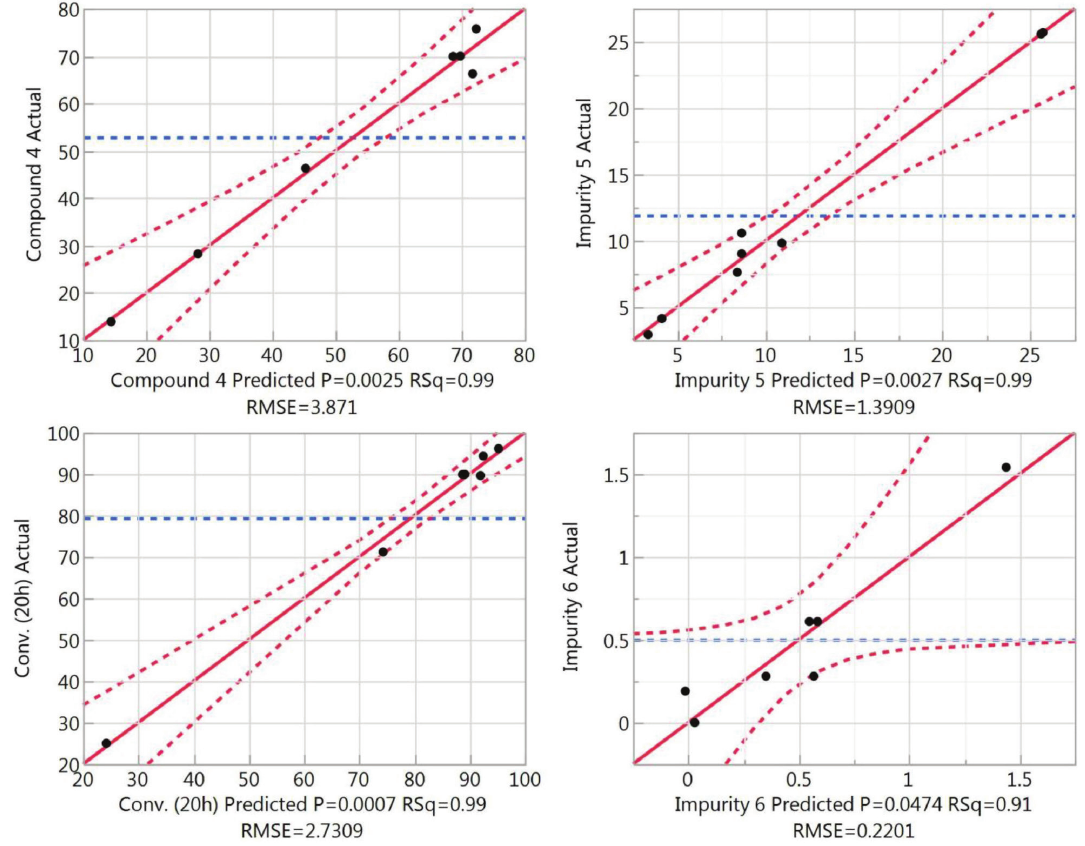
Fig. 2 – Actual vs. predicted plot with summary of fit (RSq, R 2 and Root Mean Square Error,